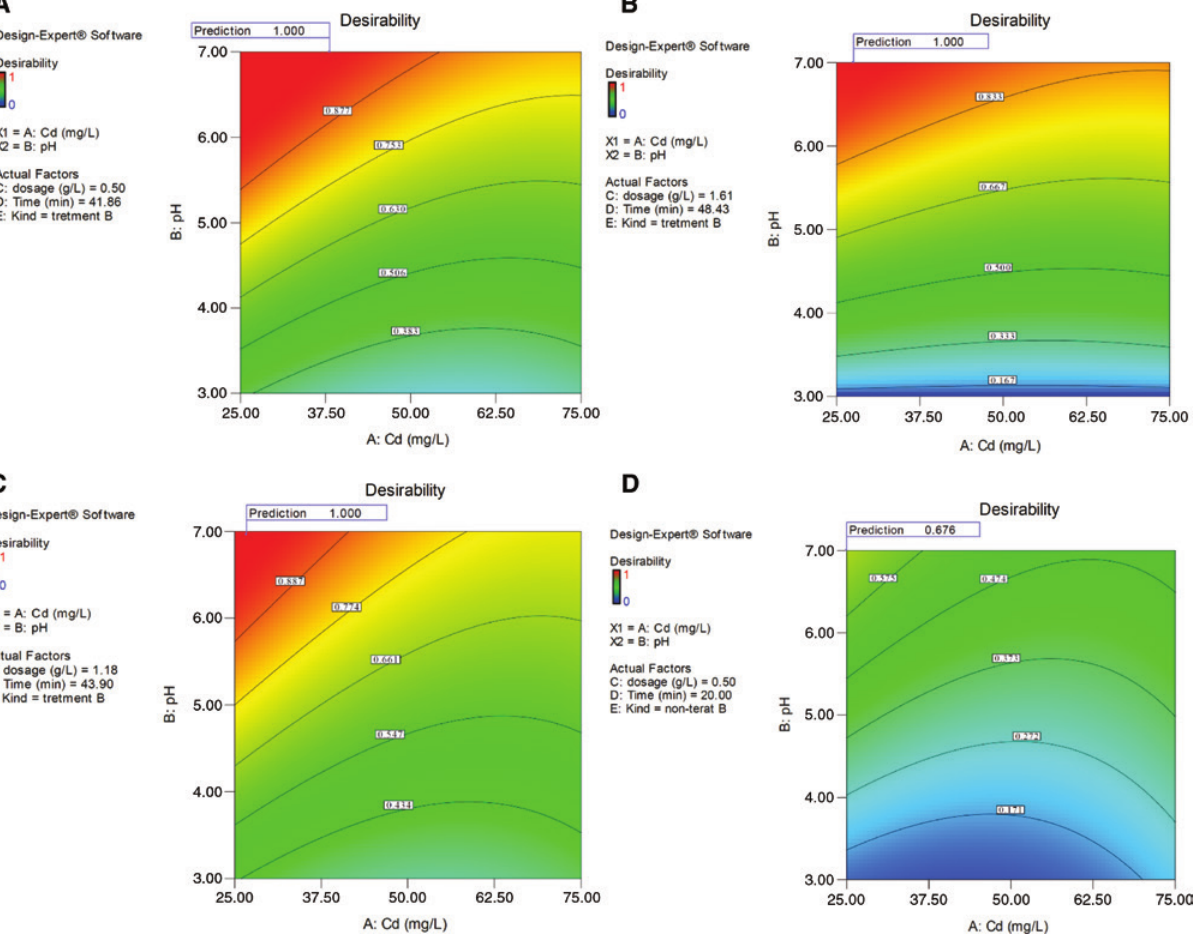
Figure 11: Contour graphs at maximum desirability and different types of goals. The contour diagrams of Cd removal efficiency (%) at maximum desirability value and different types of goals (A, all independent variables = within range and response = maximum; B, pH = maximum and other independent variables = within range and response = maximum; C, all independent variables = within range and adsorbent = PRB-nZVI; D, all independent variables = within range and adsorbent =